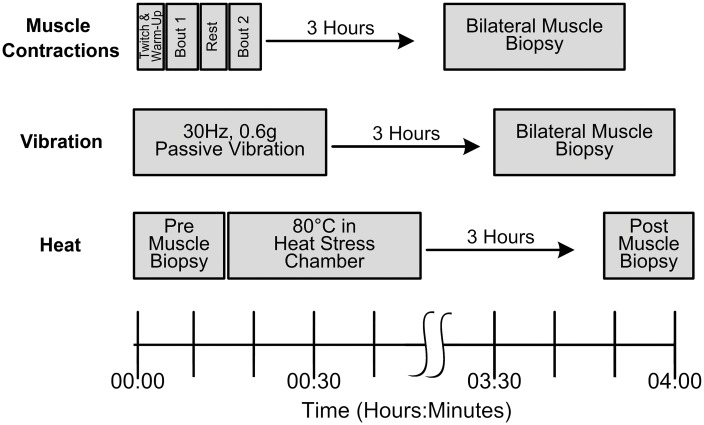
Study Timeline.The muscle contraction stressor was unilaterally delivered in two ~4-minute bouts with a 5-minute rest period between bout 1 and bout 2. The vibration stressor was unilaterally delivered in a single 30-minute bout at a oscillation frequency of 30Hz and an amplitude of 0.6g. The whole-body heat stressor was delivered in a single 30-minute bout. Three hours after the completion of each stressor a percuatneous muscle biopsy was performed. Muscle biopsies were performed bilaterally on the experimental and control limb for the muscle contractions and vibration stressors. A unilateral muscle biopsy was performed before the heat stressor on the control limb and after the heat stressor on the opposite limb due to the systemic effects of whole-body heat stress.